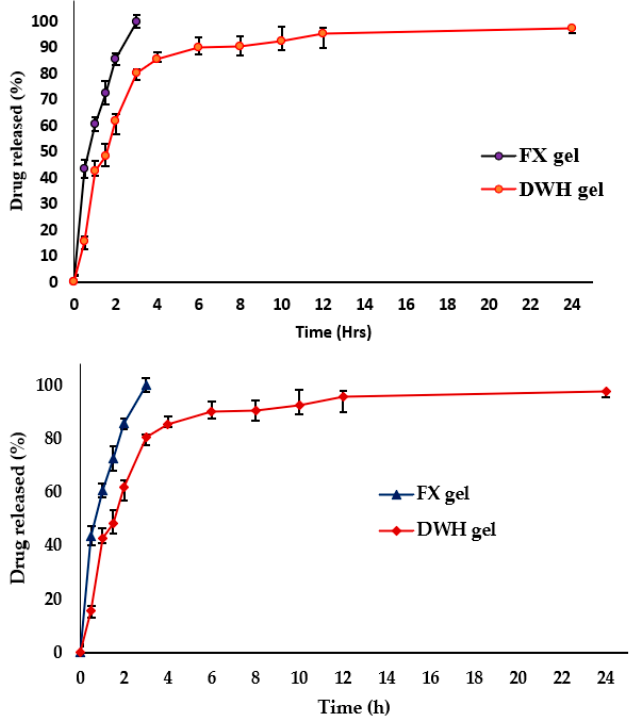
Figure 7. Drug diffusion patterns from FX plain gel and SLN-impregnated (DWH) gel.